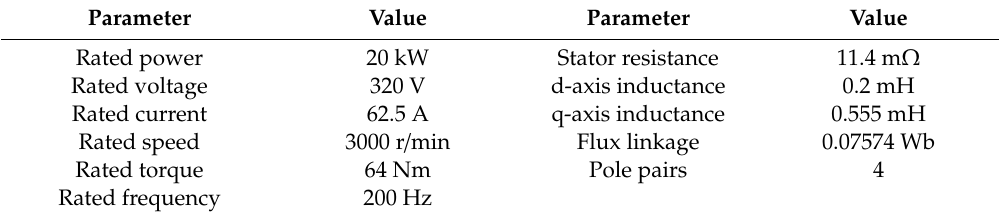
Table 1. Motor Table 1. Motor parameters.